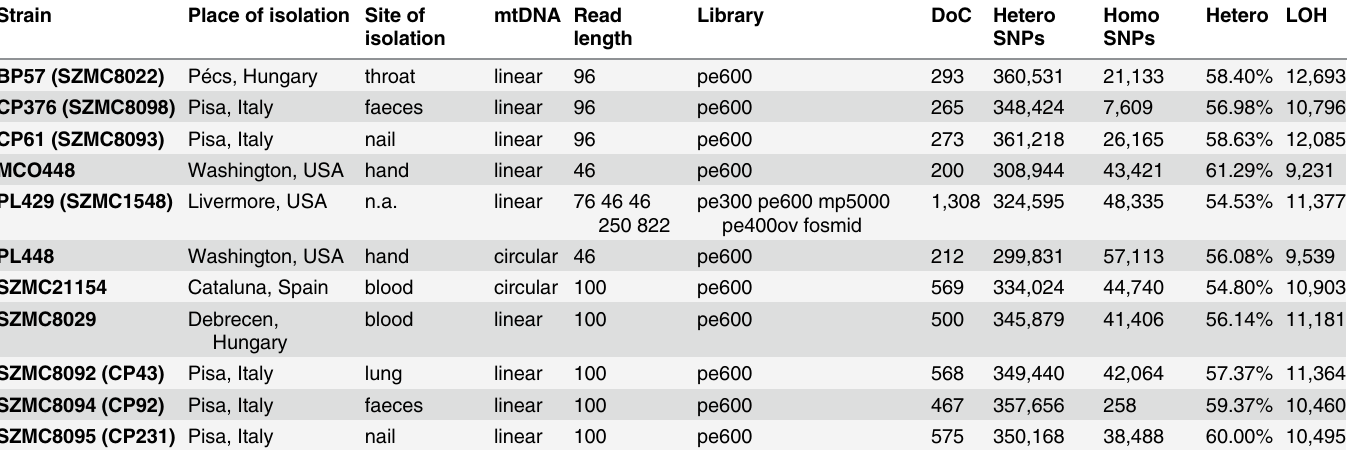
Table 1. Strain and genome sequencing stats. Basic statistics for the genomes sequenced within this work. For each strain the table provides, in this order: strain name; geographical origin; body site of isolation, type of mitochondrial chromosome, sequencing statistics including read length, type of sequencing libraries, insert size and depth of coverage (x fold); number of heterozygous and homozygous SNPs; fraction of the genome in heterozygous blocks (100 bp threshold); and minimal number of LOH events detected in that strain (100 bp threshold). pe: paired-end; mp: mate-pairs; ov: overlapping paired-end reads; pe600: paired-end reads with ~600 bp insert